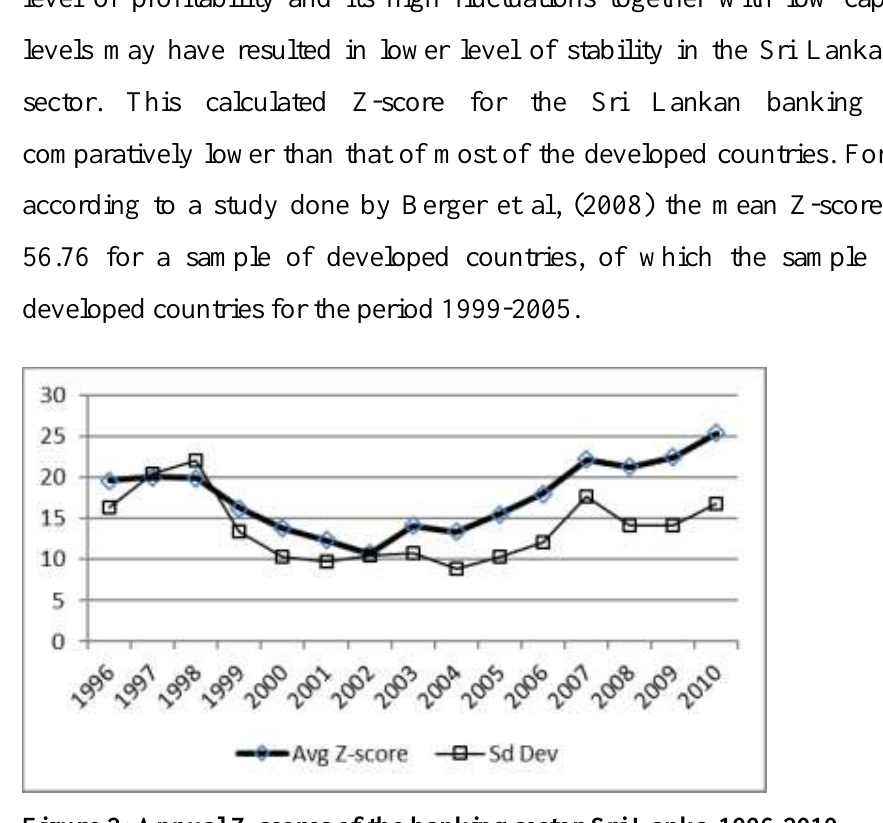
Figure 2: Annual Z-scores of the banking sector Sri Lanka-1996-2010 Source: